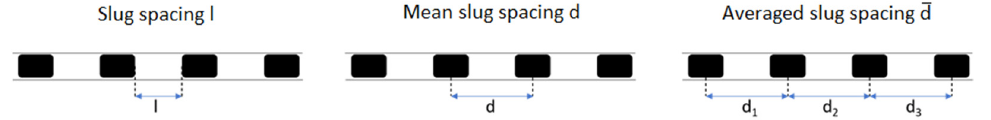
Figure A6. Difference between slug spacing, mean slug spacing and averaged slug spacing .